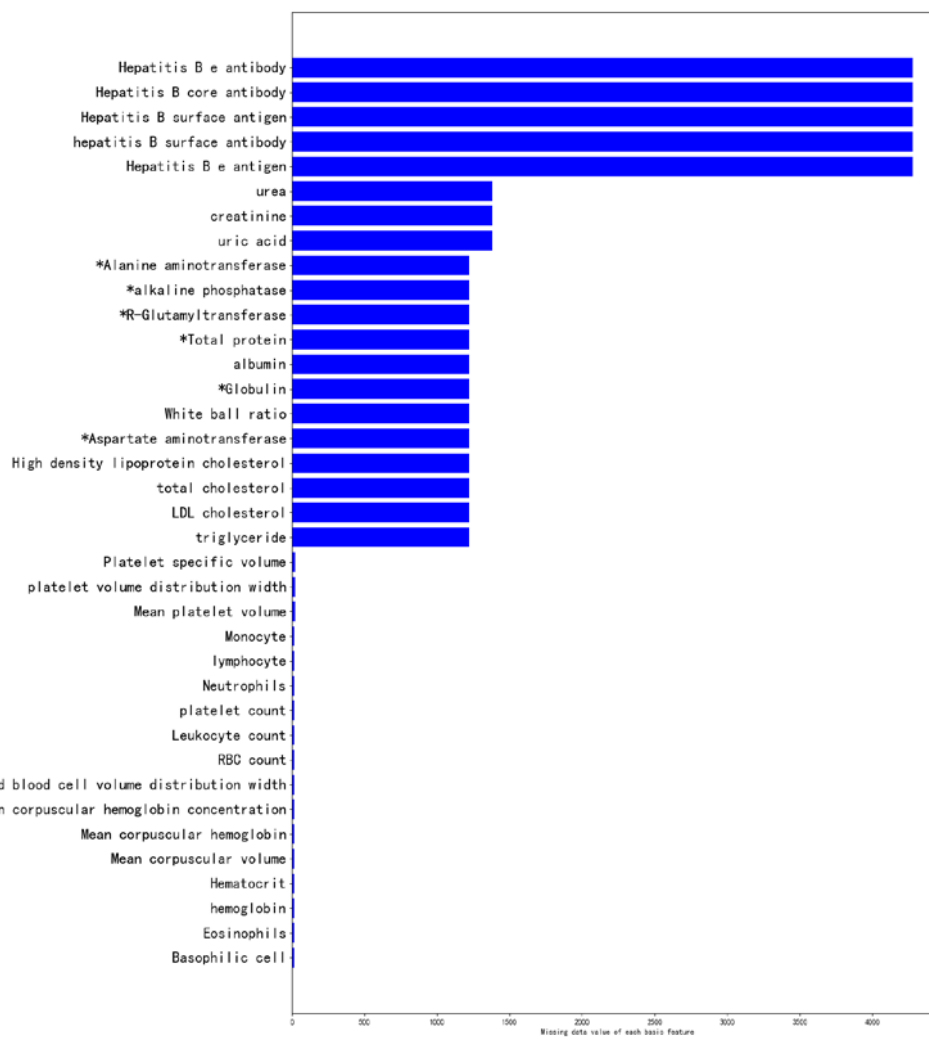
Figure 6. Feature missing scale.